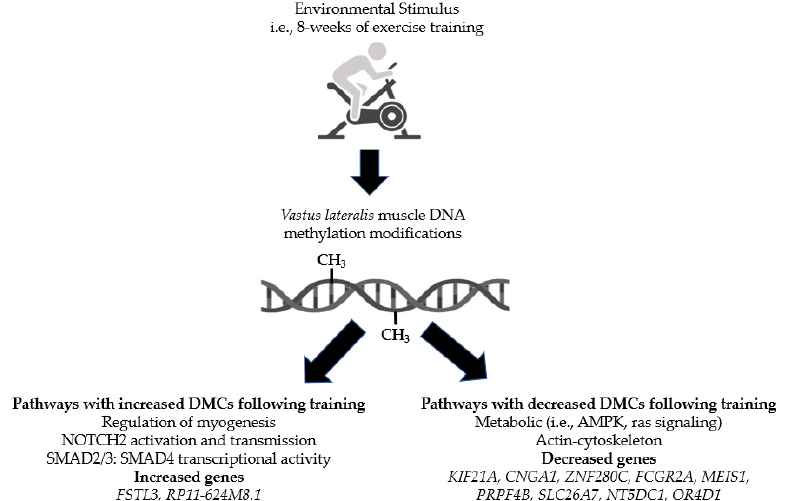
Figure 6. Summary of findings.